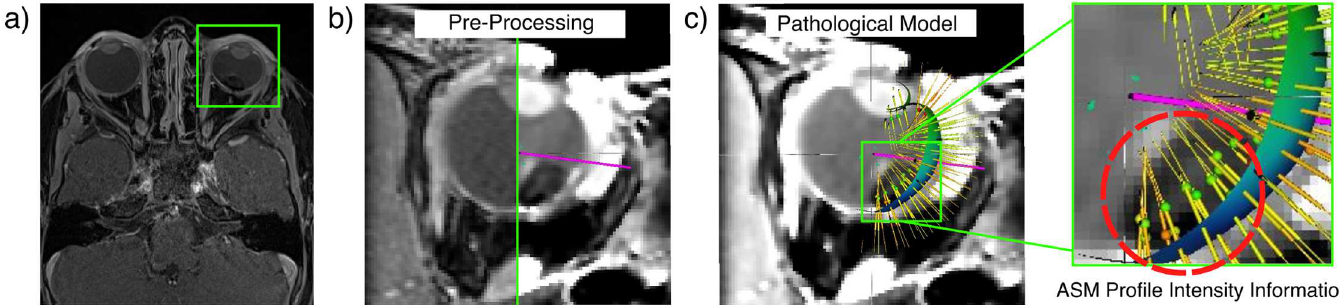
Fig 3. Learning a Pathological Eye Model (PM). We follow the steps in [15] to (a) automatically detect the eye in the 3D MRI, followedby a set of b) image pre-processing techniquesto learn informationof pathologicaland healthystructures jointly using c) intensity profiles containing pathological information.